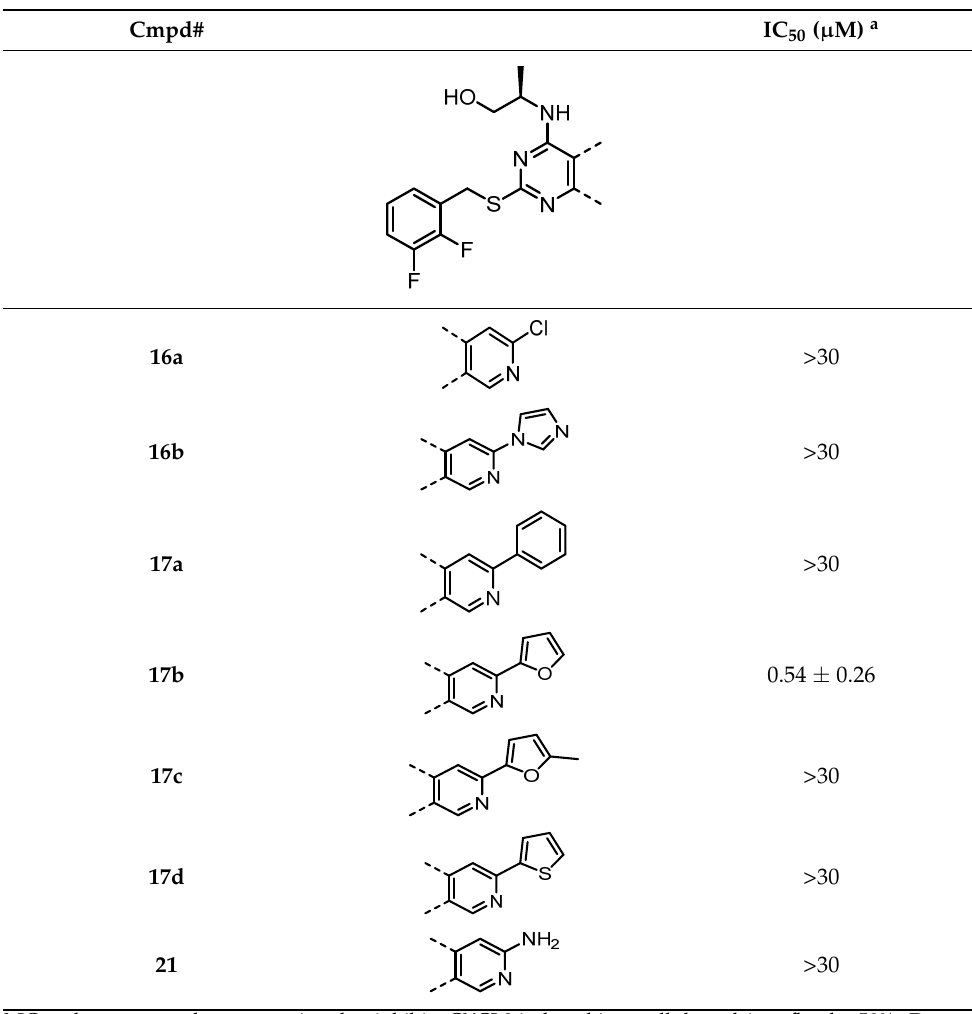
Table 1. CXCR2 antagonism of 5- and 6-substituted pyrido[3,4- d Table 1. Cont.